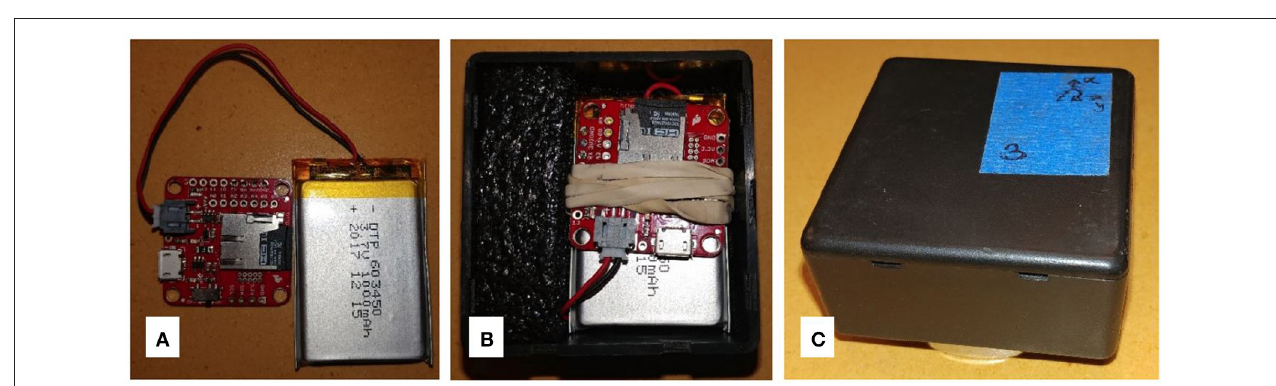
FIGURE 2 | Setup of the IMU and the protective box, IMU with battery and micro SD card (A) , IMU system placed on magnetic box (B) , protective box with number and axes tag (C)